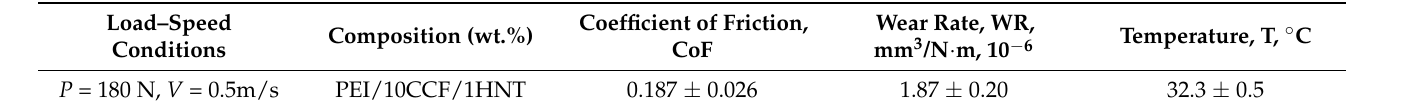
Table 9. The tribological properties of the PEI/10CCF/1CNT nanocomposite. Linear tribological contact.